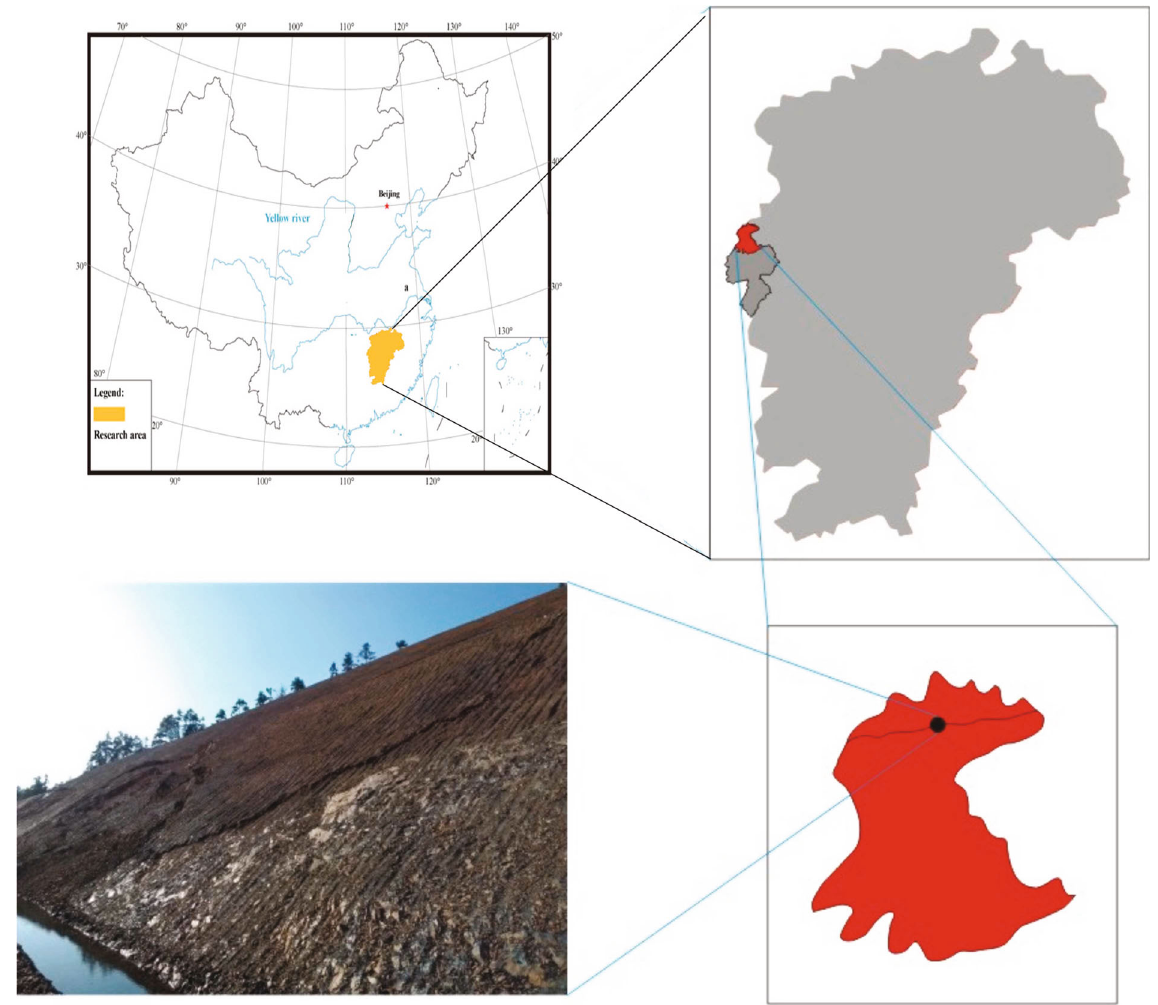
Figure 1: Sampling location.